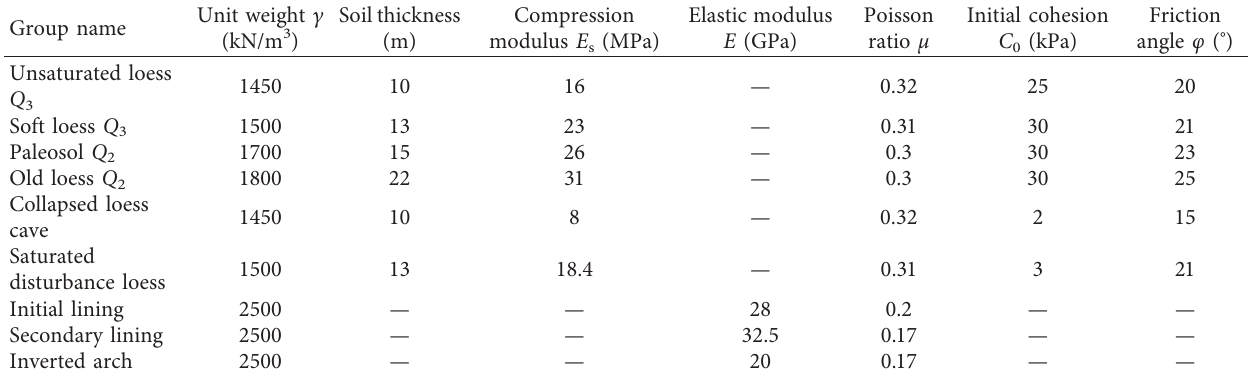
Table 2: Parameters of numerical